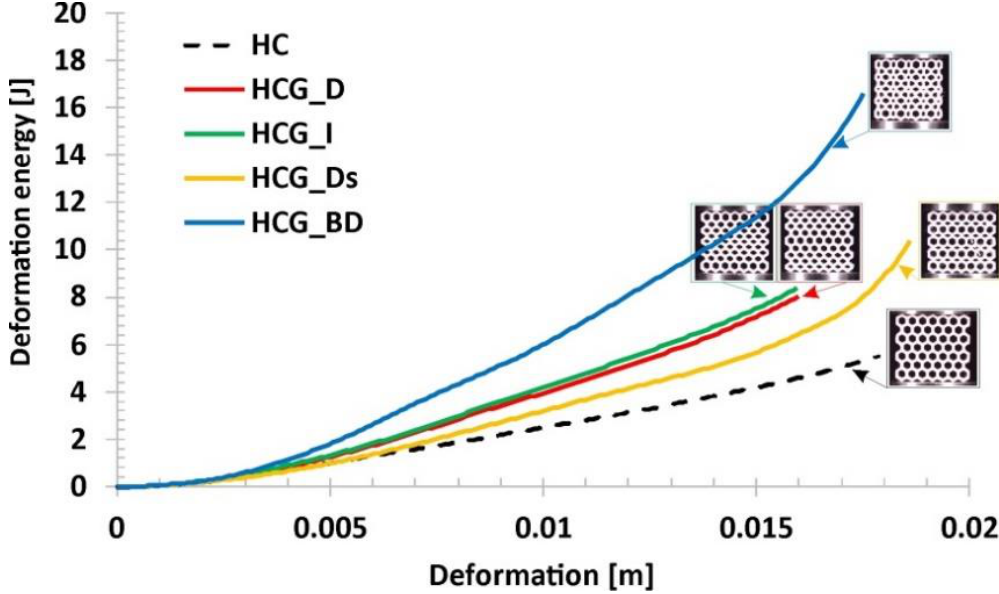
Figure 18. The comparison of the estimated values of the deformation energy versus the range of deformation.